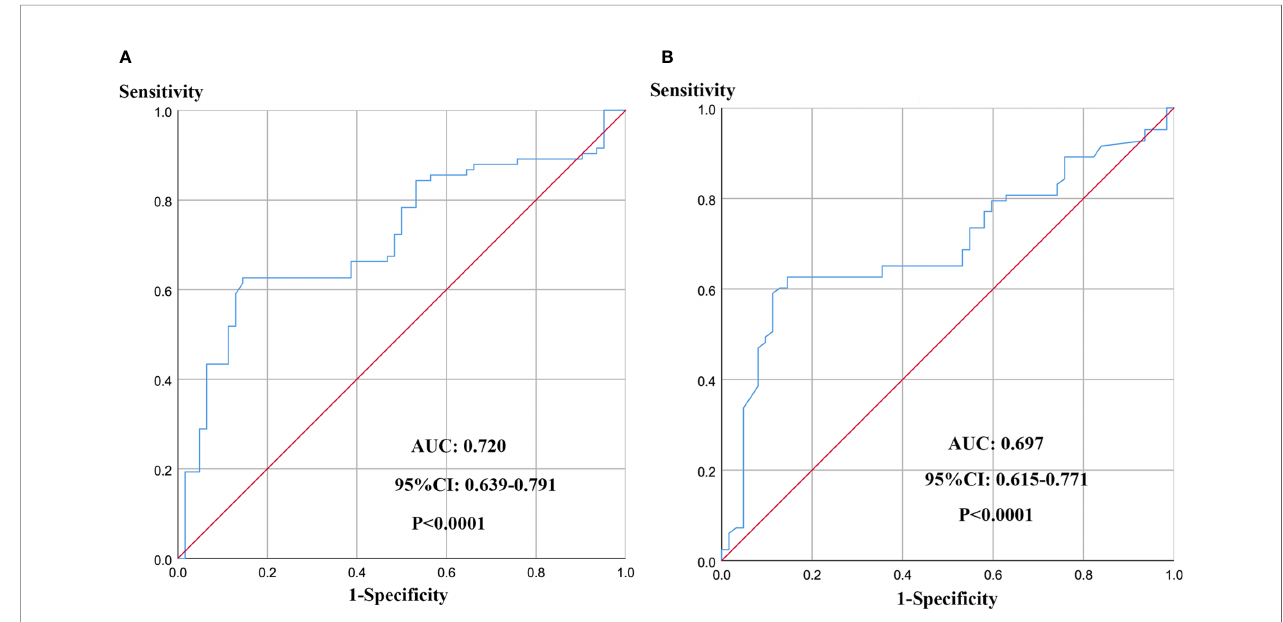
FIGURE 1 | ROC curve analysis for determination of optimal cut-off values of D-dimer (A) and PF (B) levels in 5-year